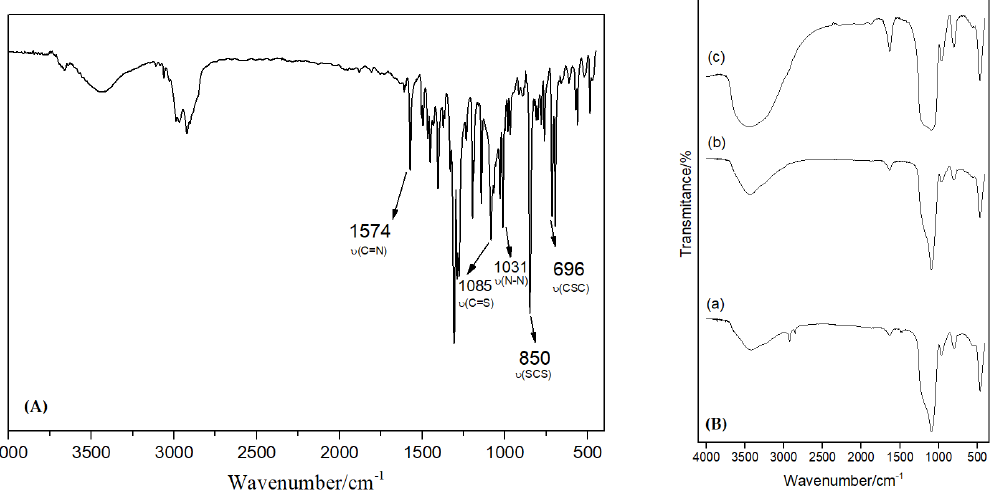
Figure 4. ( A ) Vibrational spectrum in the infrared region of the compound DTC. ( B ) Vibrational Spectrum in the infrared region of MSiNPs (a), MSiNPs calcined (b), and MSiNP-DTC (c) in KBr.